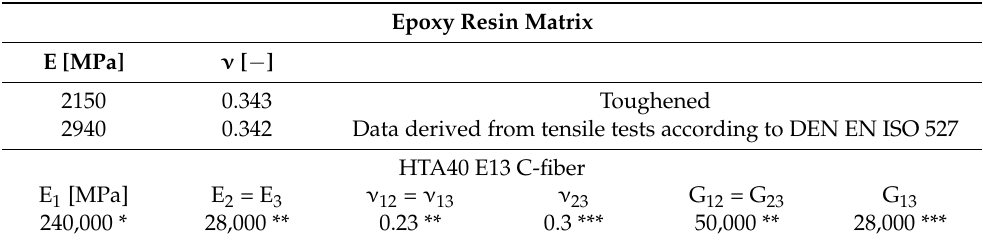
Table 1. Material data from the epoxy resin matrix and HTA40 E13 C-fiber, also used for the simplified debonding FE simulation. Epoxy Resin